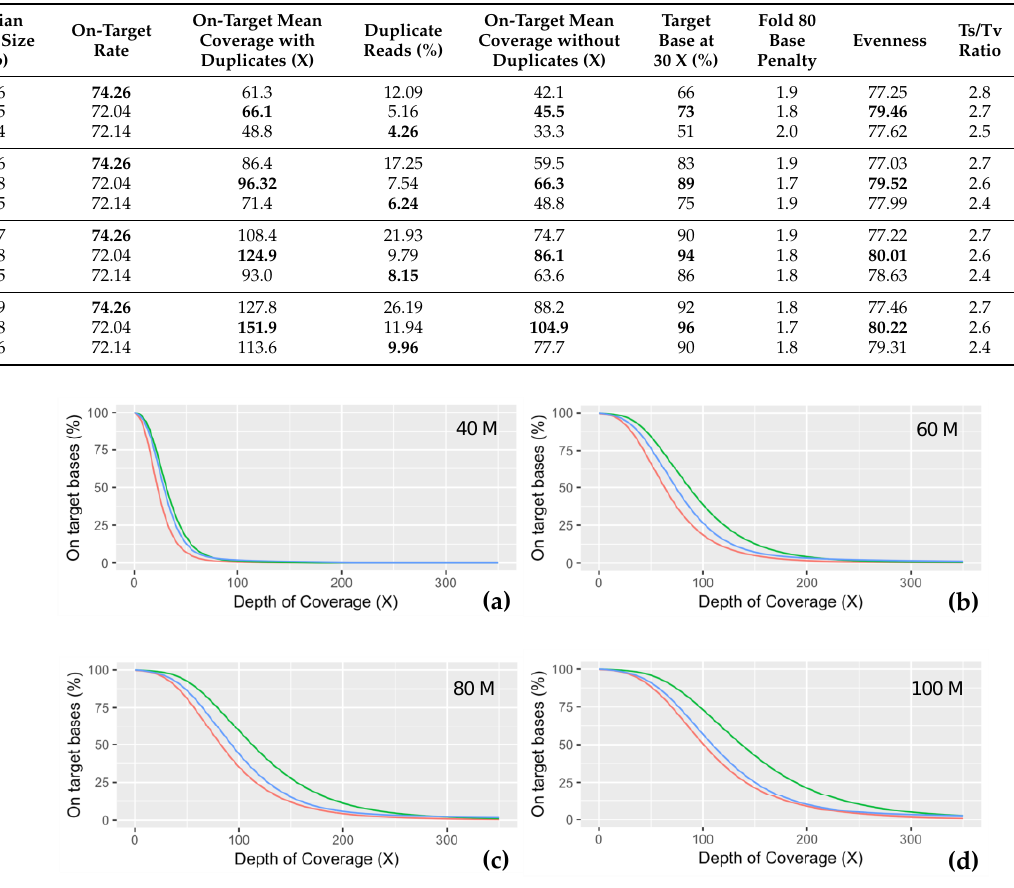
Figure 3. Coverage efficiency obtained with the different ES kits. Coverage efficiency is represented as the percent of the intended targeted bases for each technology at fixed depths (X) for different sequencing effort, simulated with a random down sampling of ( a ) 40 million reads, ( b ) 60M reads, ( c ) 80M reads, and ( d ) 100M reads.